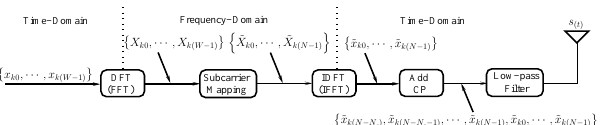
Figure 2. Transmitter schematic for the k th user supported by the SC-FDMA